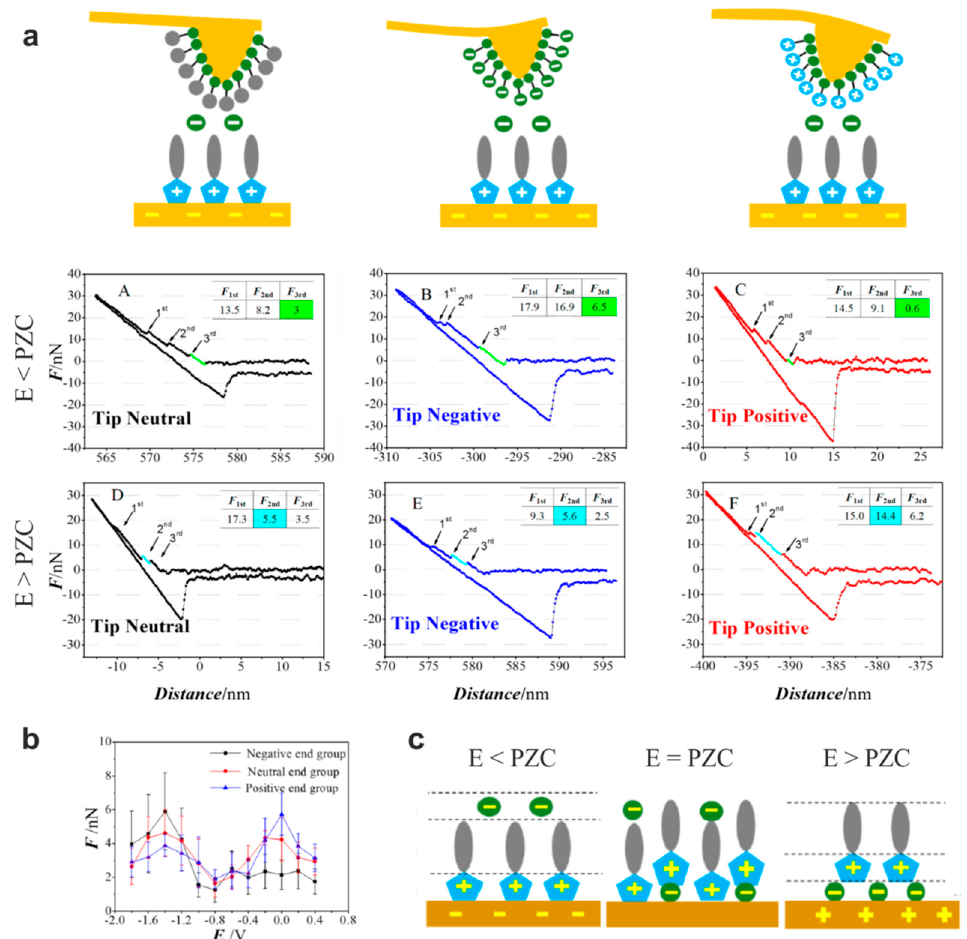
Figure 12. Measurement of the [OMIm][PF 6 ] / Au(111) interface using a modified tip. ( a ) Force–distance curves measured at a potential (E) above and below the potential of zero charge (PZC) with molecules having neutral, negative, and positive end groups attached to the tip (the inset tables display the force necessary to rupture the first, second, and third layer); ( b ) force necessary to rupture the third sublayer measured at different potentials applied to the surface; ( c ) model of arrangement of the ionic liquid at the interface depending on the potential. Adapted from Zhong et al. [85].